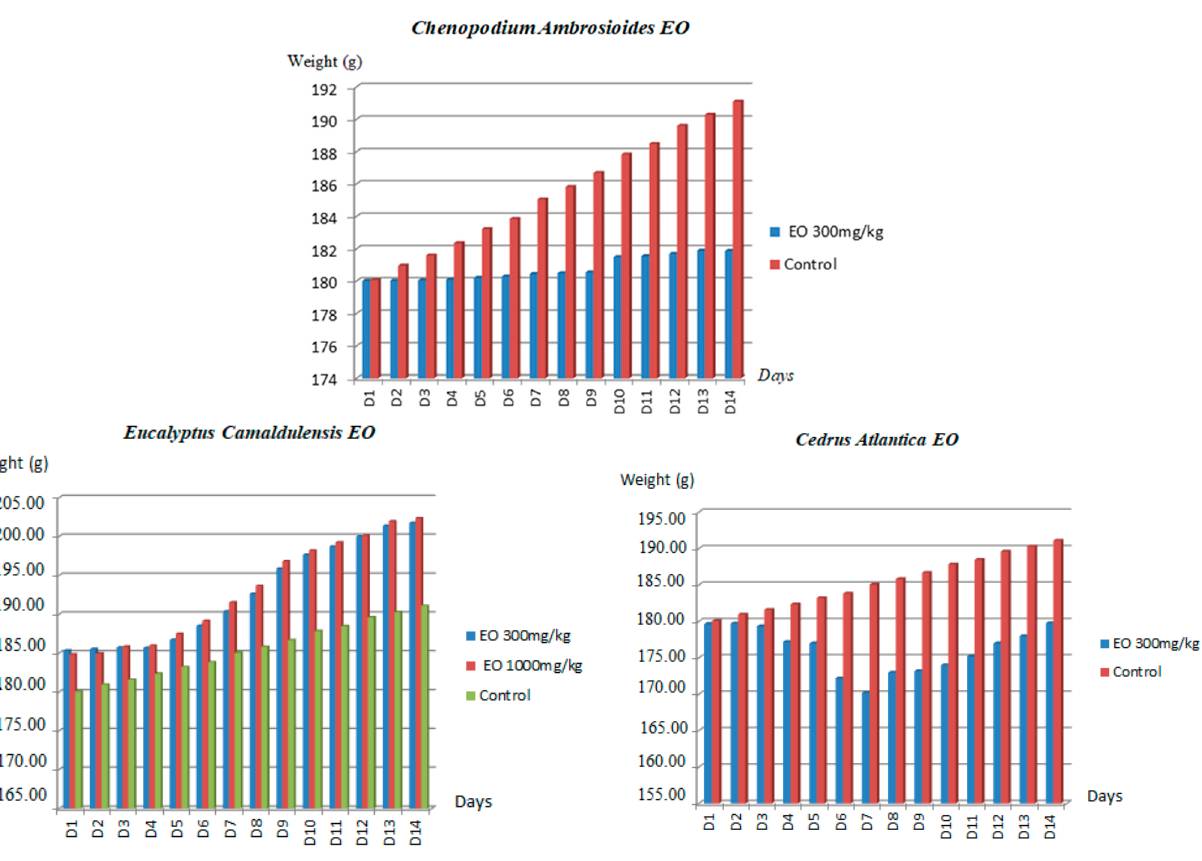
Figure 2. Variation in body weight of rats after administration of E.C , Ch.A and C.A oils during 14